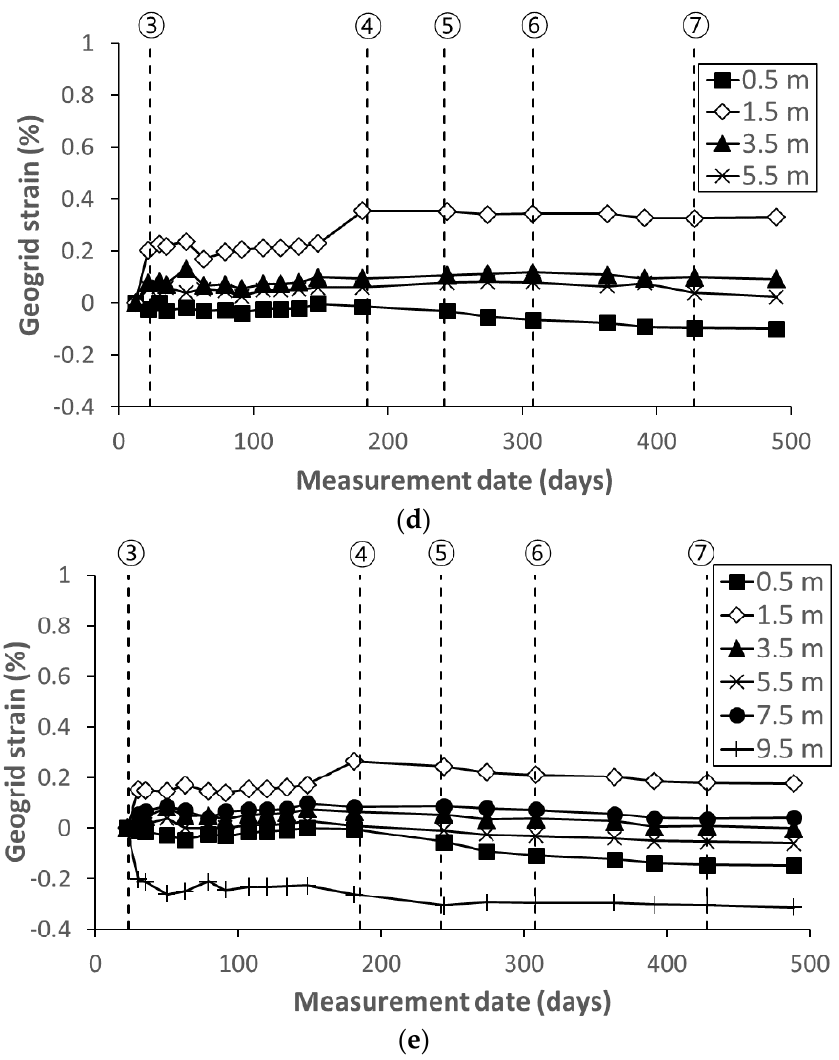
Figure 11. Variation of geogrid strain over time: ( a ) 2nd layer (short geogrid); ( b ) 5th layer (short geogrid); ( c ) 10th layer (long geogrid); ( d ) 13th layer (long geogrid); ( e ) 16th layer (long geogrid).